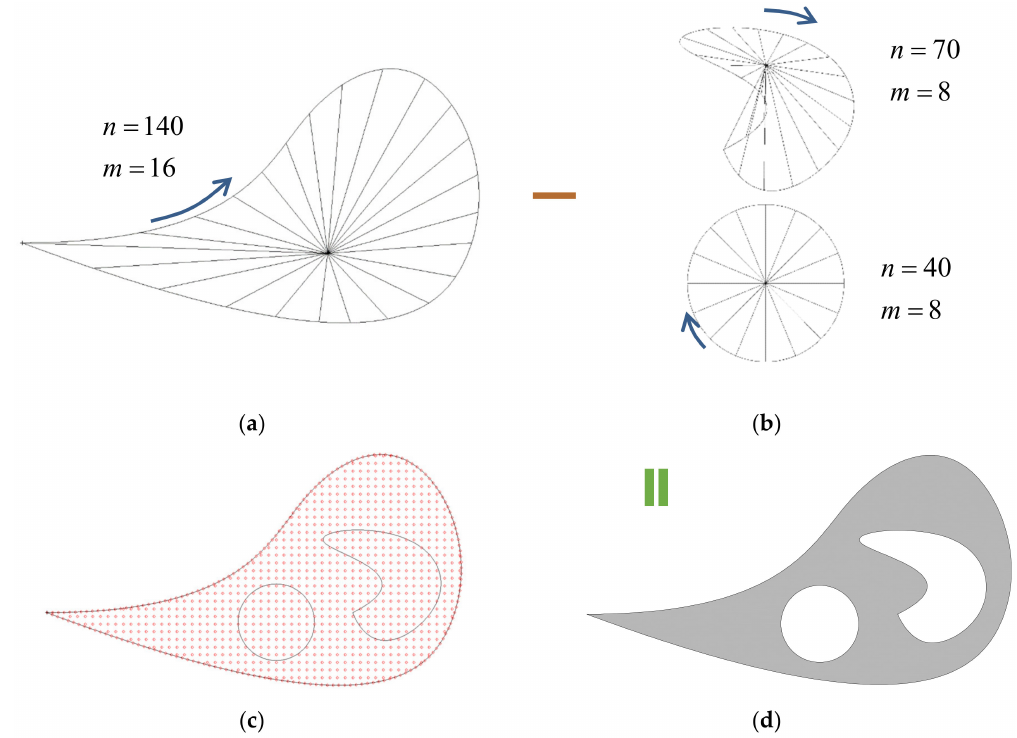
Figure16. DiscretizationofRSUBinapoint-stylehomotopicmesh: ( a )predesigneddomain, ( b )arbitrary holes, ( c ) deployment of field nodes, ( d ) actual equivalent